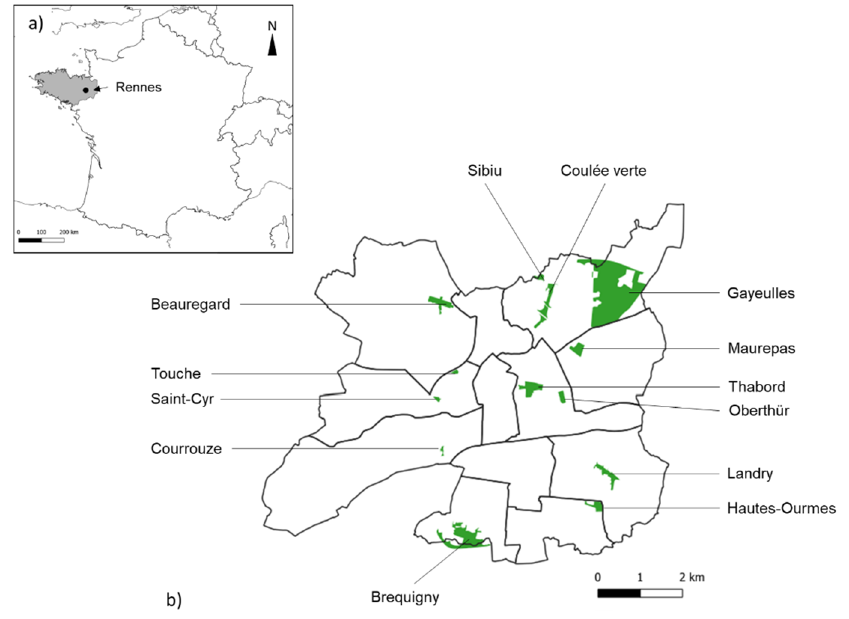
Figure 1. Study area. ( a ) Rennes city (Brittany, France) location map. ( b ) Location of the 13 urban green spaces (UGS) throughout the 12 neighborhoods of Rennes.